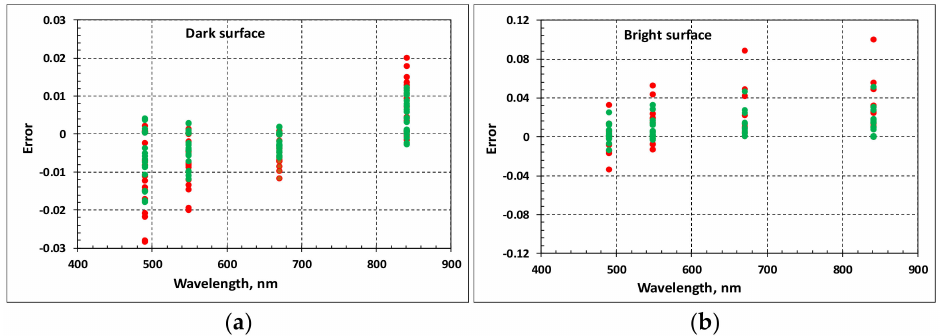
Figure 7. Errors in retrieving surface spectral reflectance in the MZ channels for dark surfaces ( a ) and bright surfaces ( b ) at solar zenith angles 60 ◦ (red circles) and 20 ◦ (green triangles). Radiometric calibration error in the MS channel 412 nm is 5%.